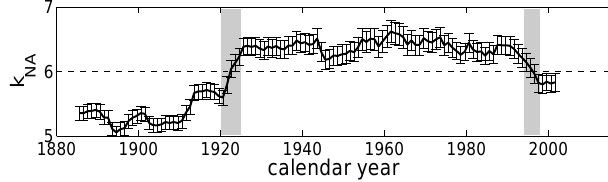
Figure 8. Running means and standard deviations (window width 270 months) of the degree sequence of the VG constructed from the normalized area difference series NA. Areas shaded in gray indicate the hypothesized transitions in the dynamics of interhemispheric ac- tivity differences, which are similar to those shown by the excess degree of the VGs for A N and A S (Fig.